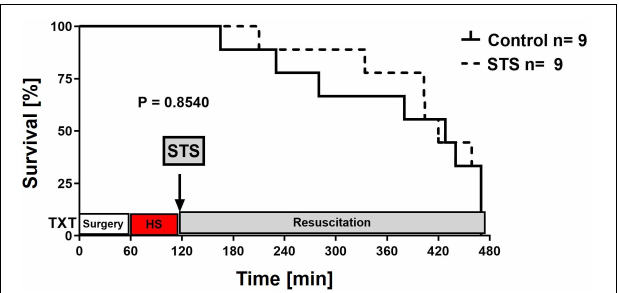
FIGURE 3 | Survival curves. Survival curves were compared using the Log-rank (Mantel–Cox) test.